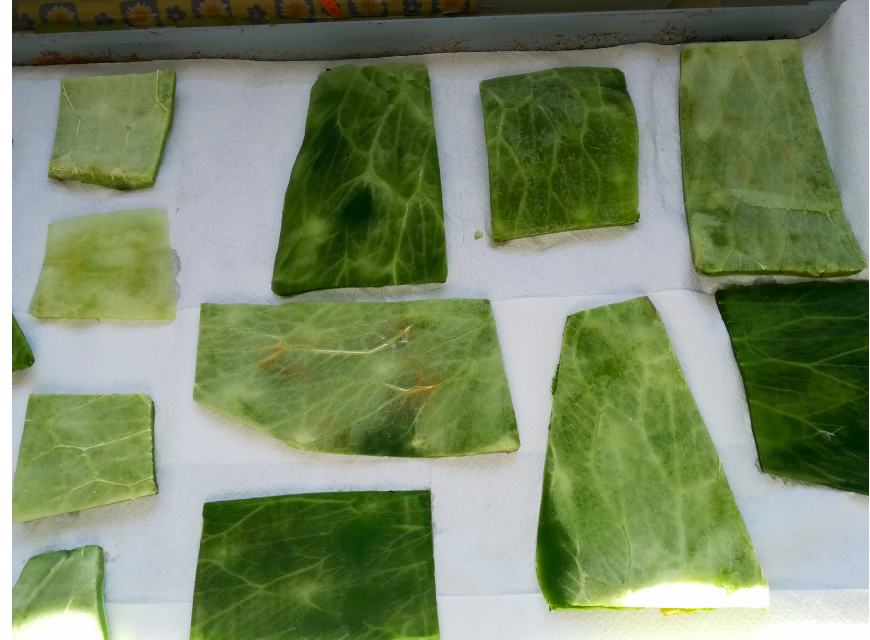
Figure 1. Cladodes after cutting for mucilage isolation, before starting the different procedures.